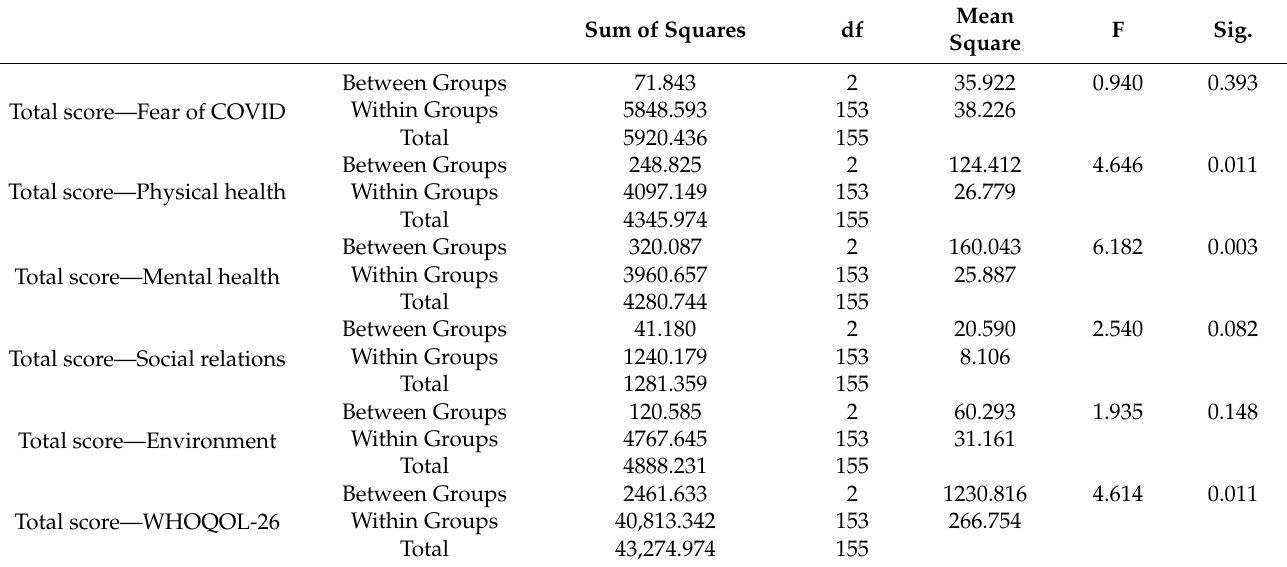
Table 3. Cross-reference between educational level and the participants’ responses to the questionnaires.